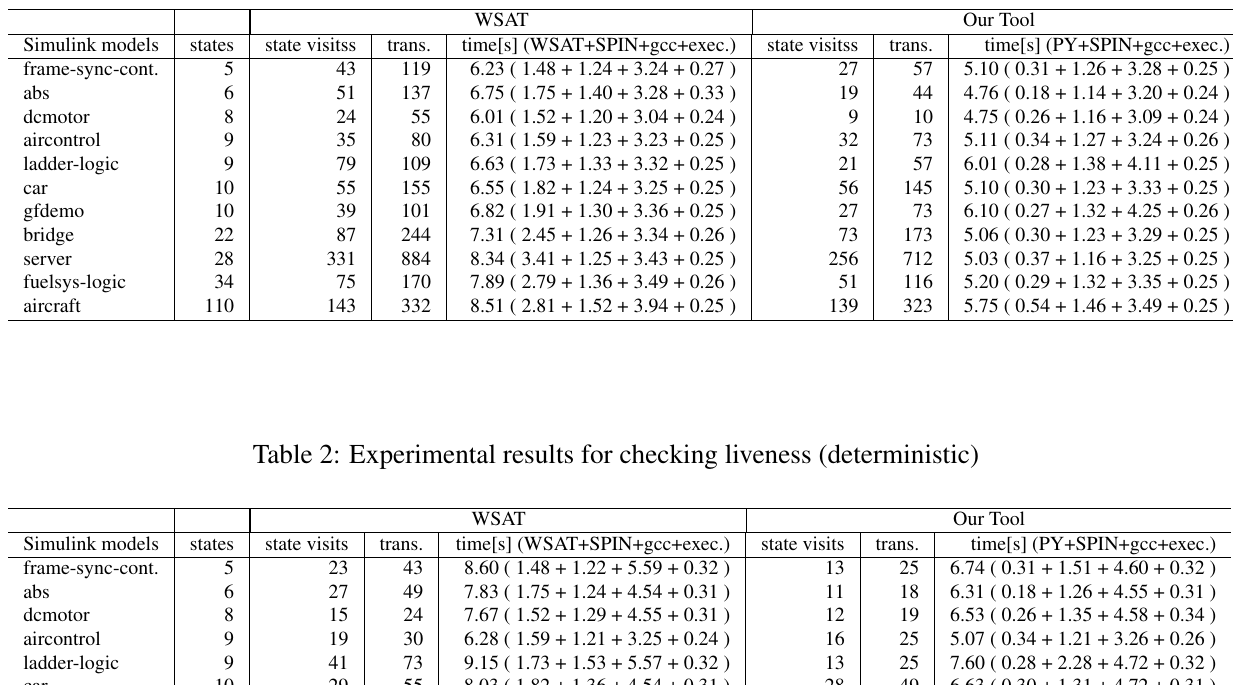
Table 1: Experimental results for checking reachability (deterministic) Simulink models